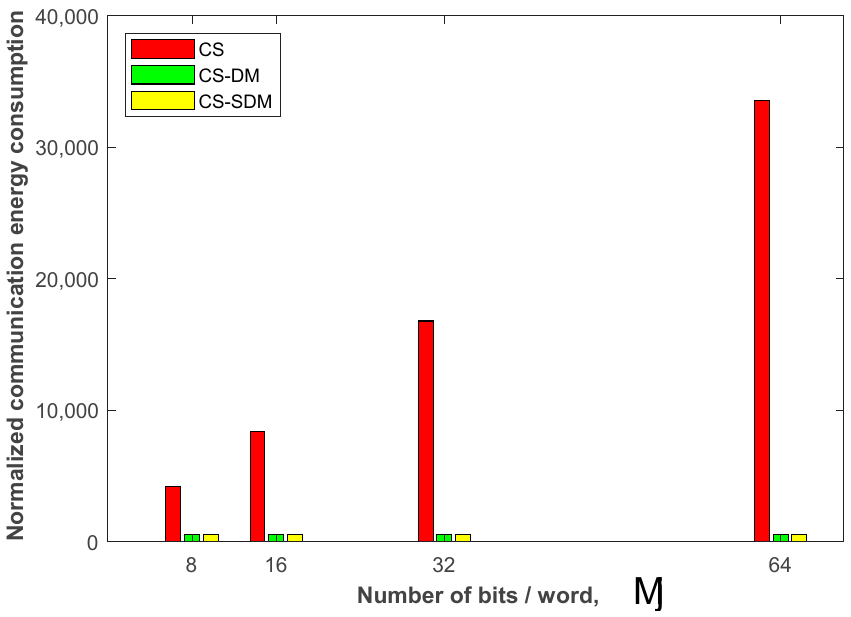
Figure 16. Normalized communication energy consumption for the three localization systems versus the number of bits/word ( Ɱ ) of the original TOA samples. R = 3, N = 5, path length = 315.